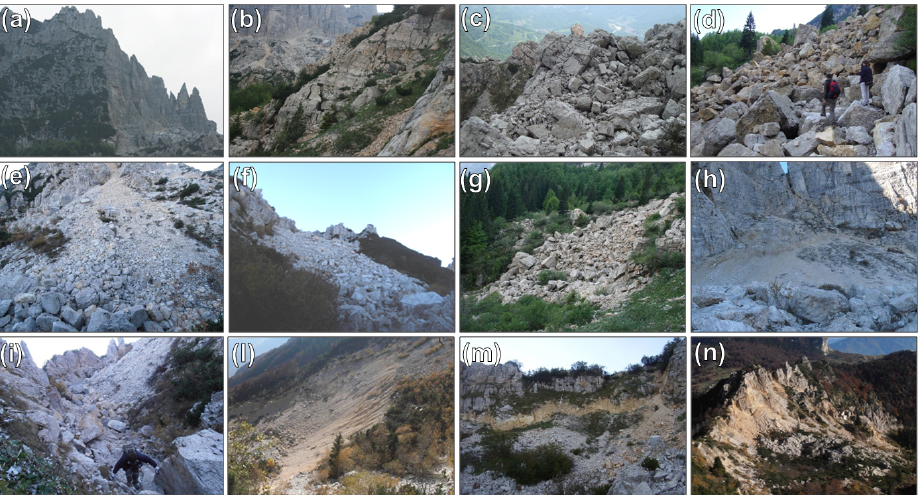
Figure 4. Geomorphic and sedimentary features of the Mt. Rotolon DSGSD detachment sector: (a) rock walls prone to rockfalls; (b, c) rock mass affected by different stages of disaggregation; (d) plurimetric rock blocks within rock avalanche deposit. Main depositional elements within the landslide body: (e) colluvial fan; (f, g) channelized and diffused rockfall deposits; (h) colluvial aprons. Main landslide linear elements: (i) landslide trench; (l) 2010 debris flow detachment scarp; (m) DSGSD crown sector; (n) landslide